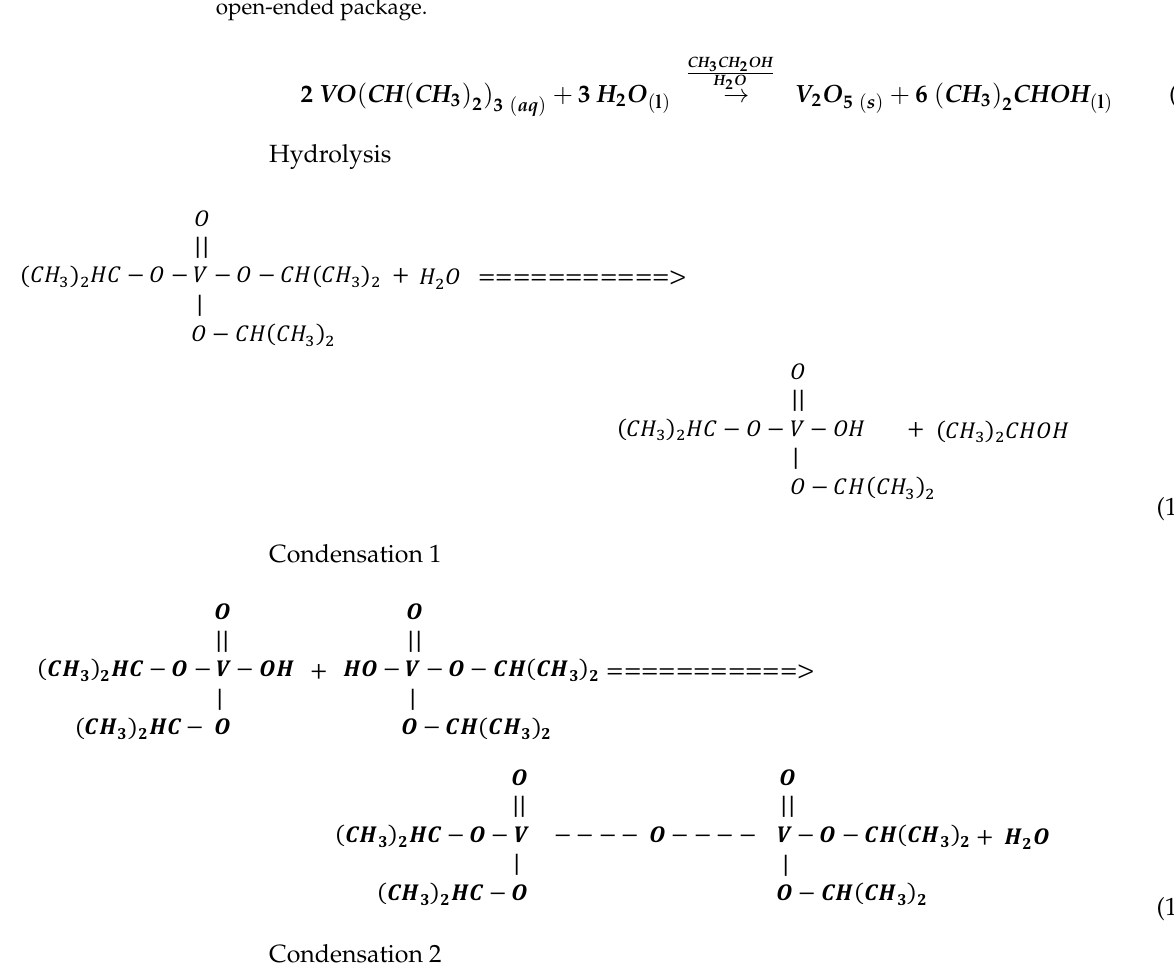
Figure 3. TEM micrographs of vanadium oxide nanotubes VOx-NTs: ( a ) single nanotube exhibits the micrometric, hollow center inner and outer diameter; ( b ) nanotube walls made of V 7 O 162 − lattice embedded with self-assembled long alkyl chain amines; the dark fringes correspond to V 7 O 162 − ; host lattice colorless fringes in-between are associated with the embedded organic amines; and ( c ) tubular open-ended package.